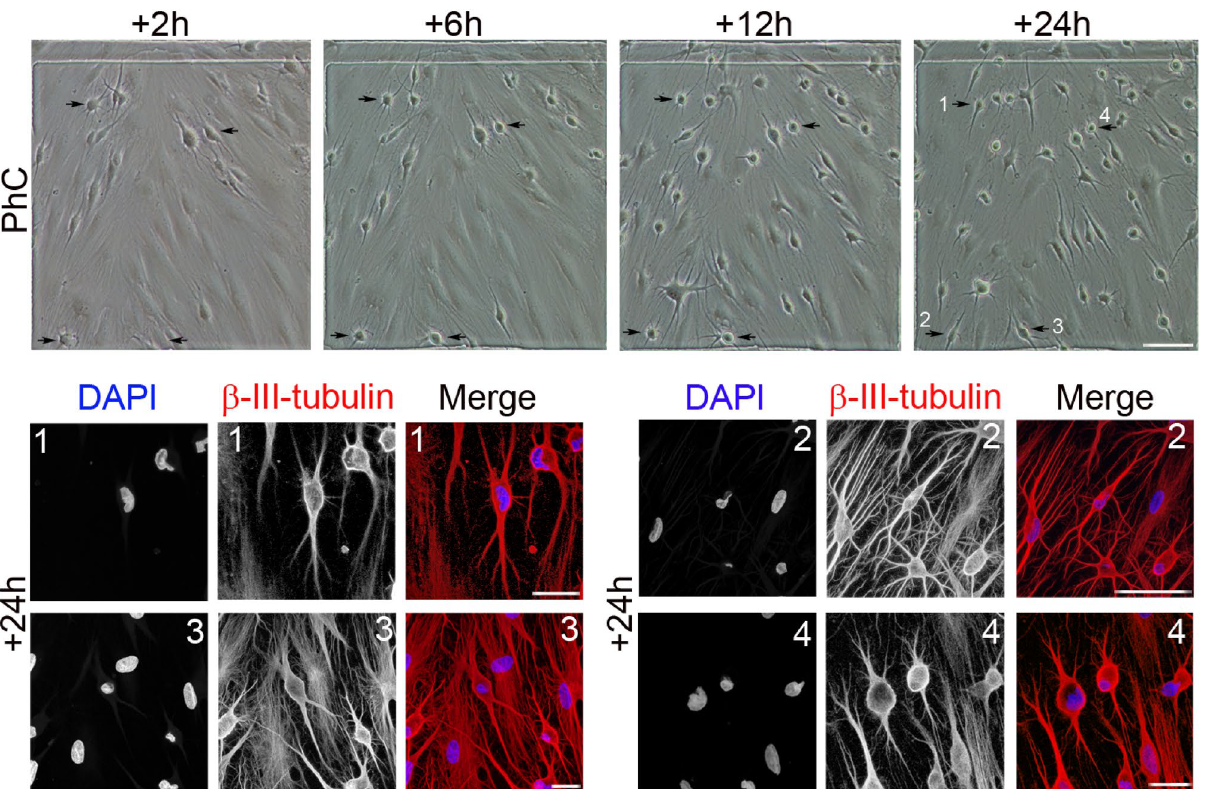
Figure 1. Morphological changes in hPDLSC cultures during neural induction. Time-lapse imaging and immunocytochemical analysis revealed that, after neural induction, hPDLSCs underwent a rapid change in shape and size, first adopting highly irregular forms and then gradually contracting into round cells. Subsequently, there was growth of new neurites from the cell body of round cells (black arrows) (numbers correspond to the areas shown in higher magnifications). The scale bars are 100 μm in the phase-contrast photomicrographs, and 25 μm for confocal micrographs. PhC: Phase-contrast